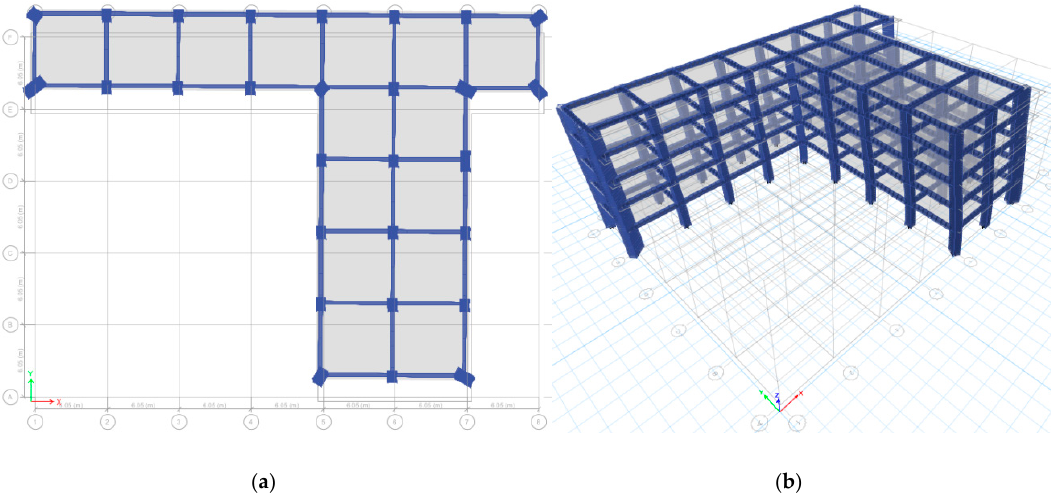
Figure 11. The 1st mode shape for T 1 = 0.449 s: ( a ) plane view, and ( b ) 3D view.